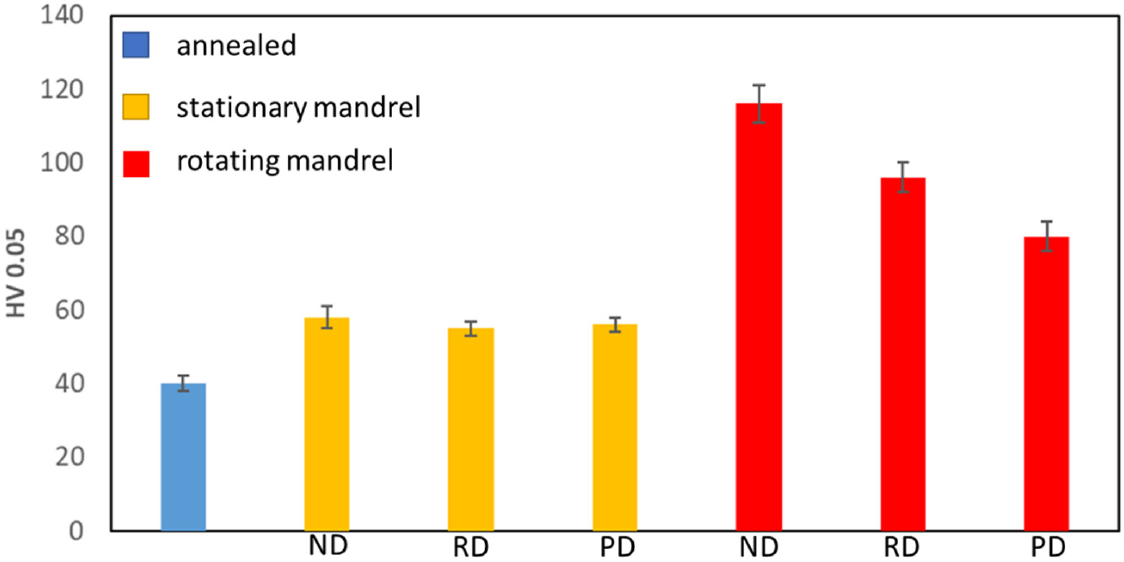
Figure 9. Evolution of microhardness during CSET with stationary and rotating mandrel.